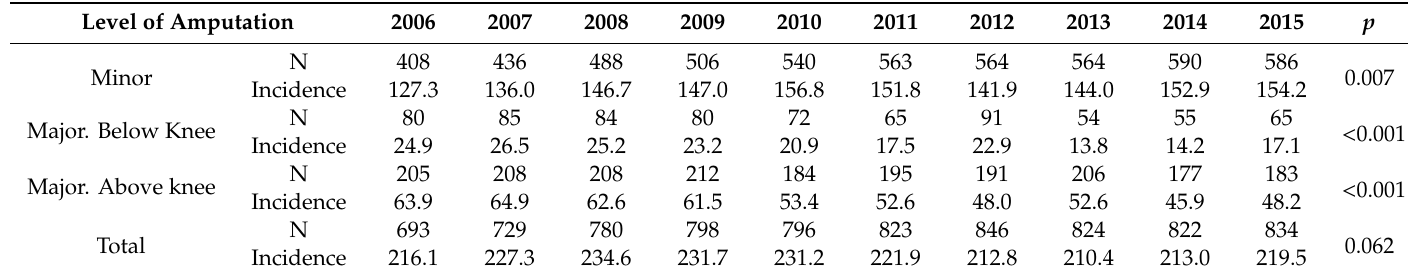
Table 1. Trends 2006–2015 in lower extremity amputations (LEAs) among type 2 diabetes mellitus (T2DM) patients in the Autonomous Community of